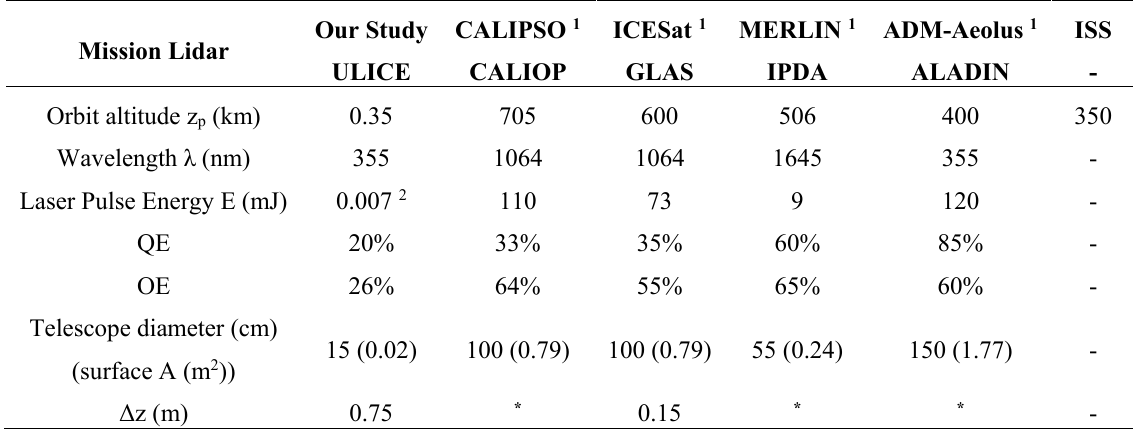
Table 3. Actual parameters for ULICE and referenced spaceborne lidar missions. Our Study Mission Lidar ULICE Orbit altitude z p (km) 0.35 Wavelength λ (nm)